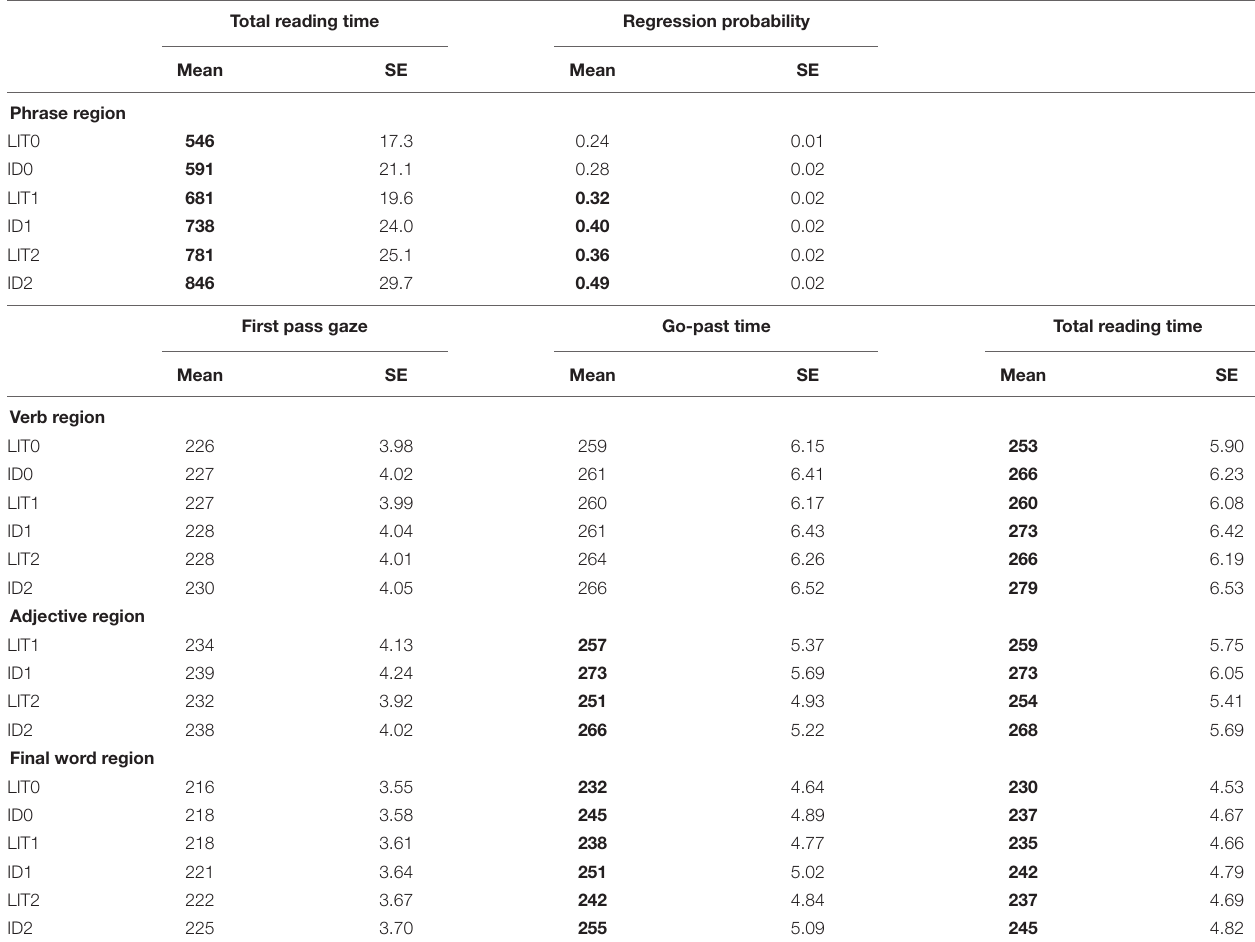
TABLE 3 | Model means collapsed across ROI and